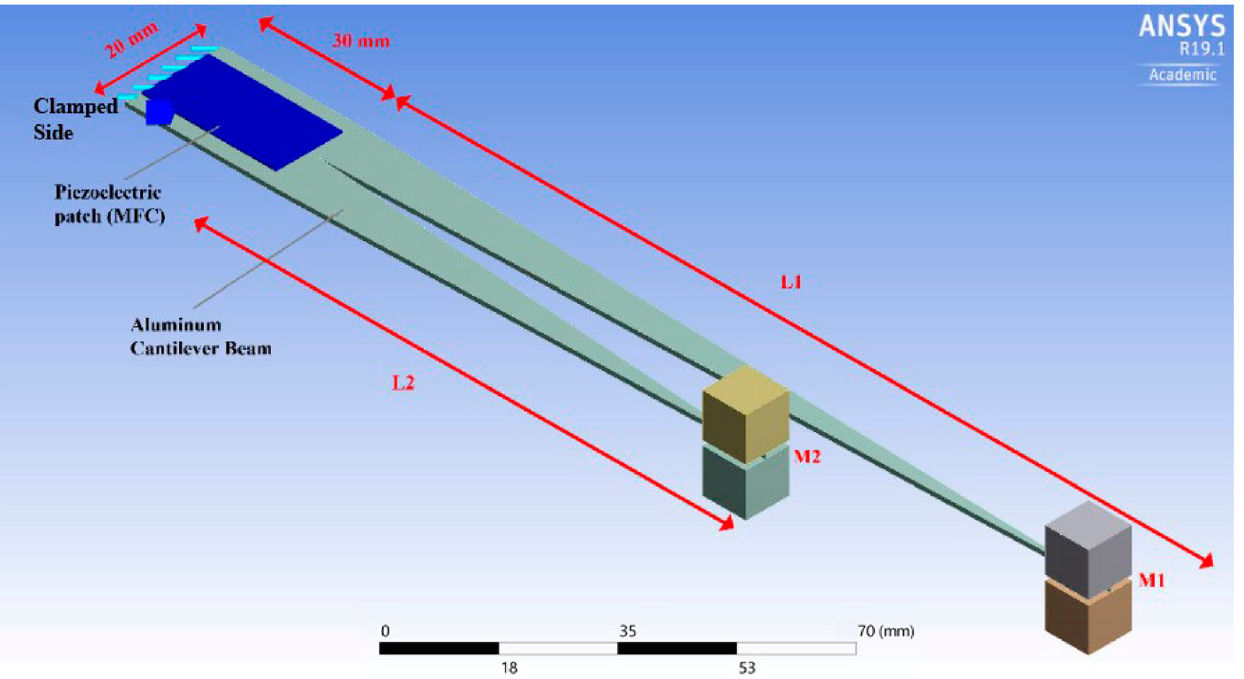
Figure 4. Schematic of a multi-resonant piezoelectric energy harvester design adopted from [28].